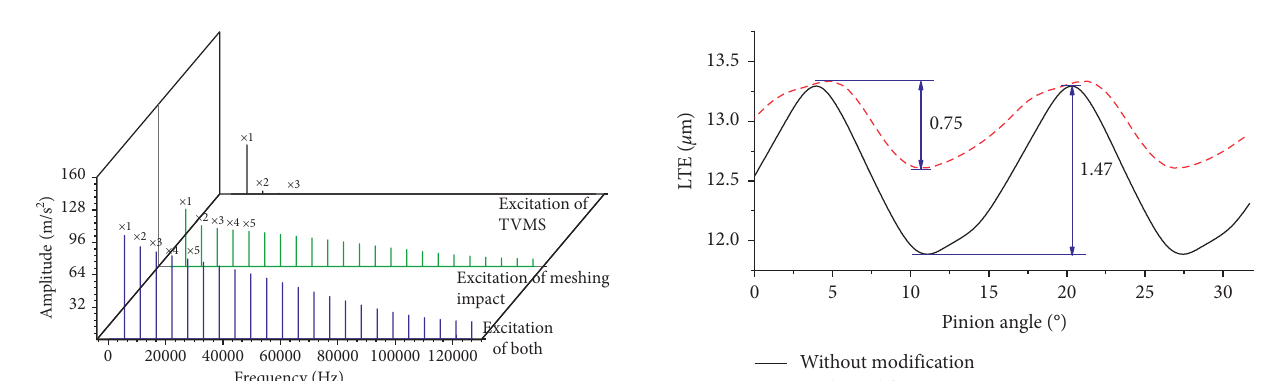
Figure 22: Frequency-domain diagram of single-stage helical gear transmission system at